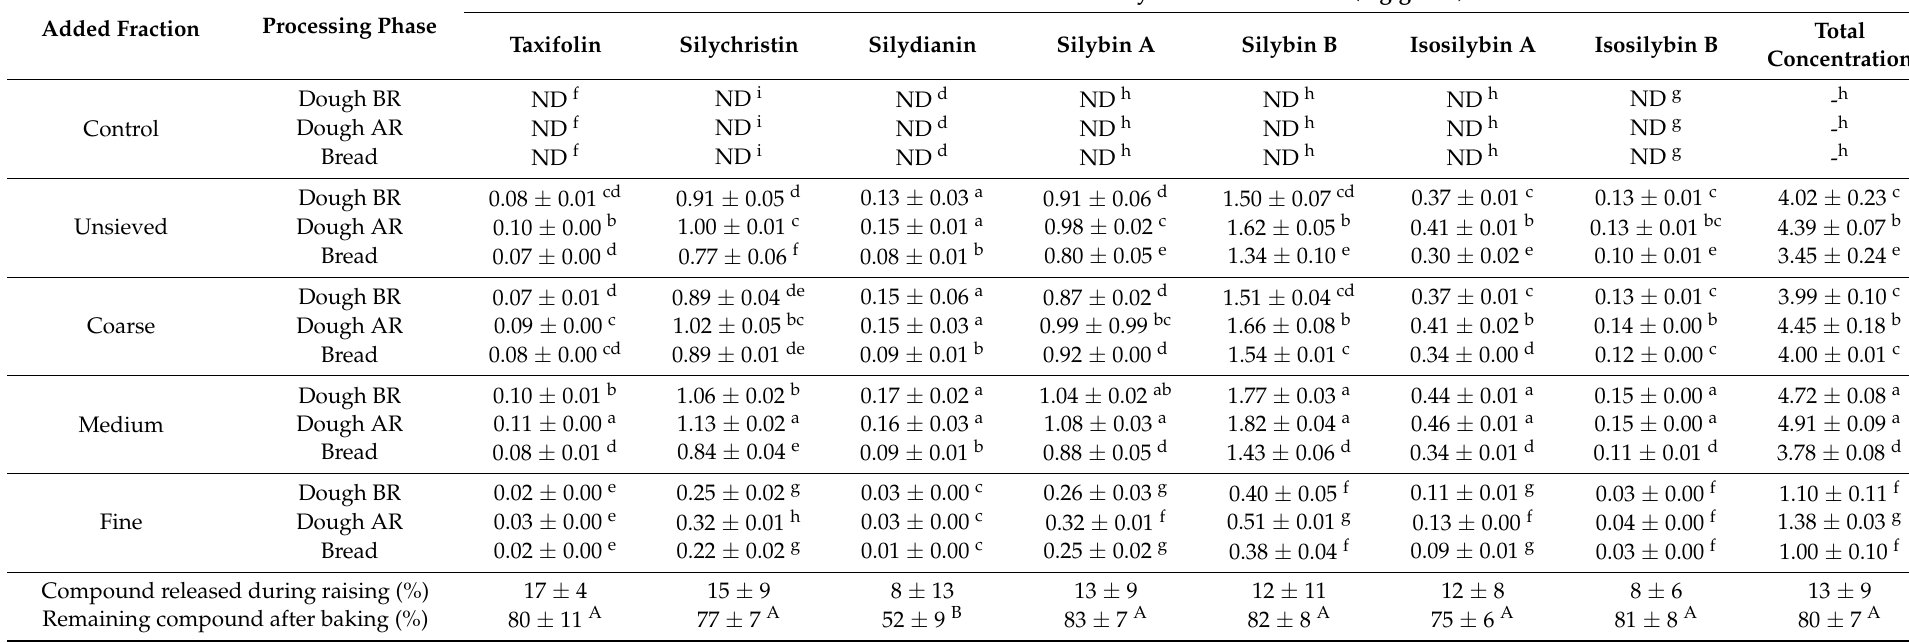
Table 3. Content of silymarin constituents in dough samples before and after raising and bread samples fortified with different milk thistle oilseed cake flour